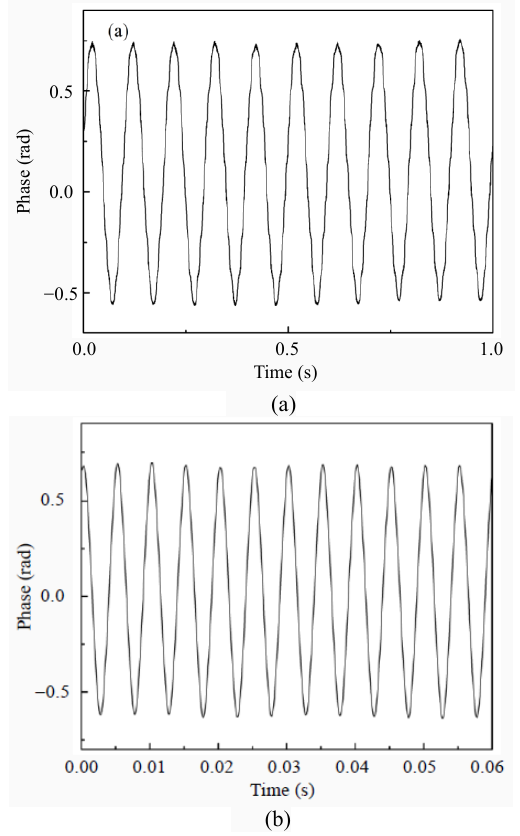
Fig. 5 Time domain signal of (a) 10 Hz and (b) 200 Hz.